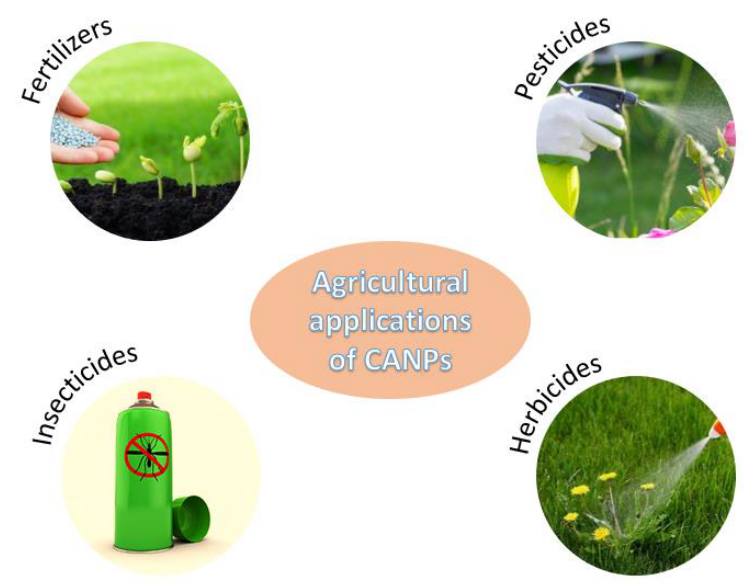
Figure 10. Examples of chitosan-alginate-based nanomaterials applications in agriculture.